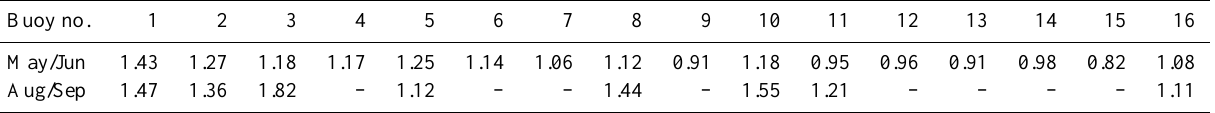
Table 3. Average ratios of U i / U g in % during the periods May/June and August/September 2007 for all 16 D07 ice buoys. The distance between the D07 array locations for both periods is relatively small. The centre of the array is at 88.2 ◦ N, 080 ◦ E (86.3 ◦ N, 020 ◦ E) in the middle of the first (second)